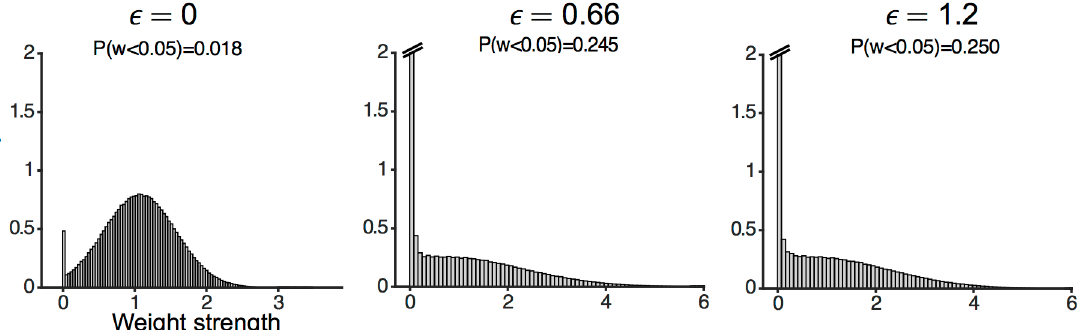
Fig 8. Synaptic weight distributions. Comparing the distributions of the synaptic weights at critical capacity for three different values of robustness obtained from simulation. The distribution of weights approaches a Dirac-delta distribution at zero plus a truncated Gaussian. As the patterns become more robust, the center of the partial Gaussian shifts towards the left, and the number of silent synapses increases.